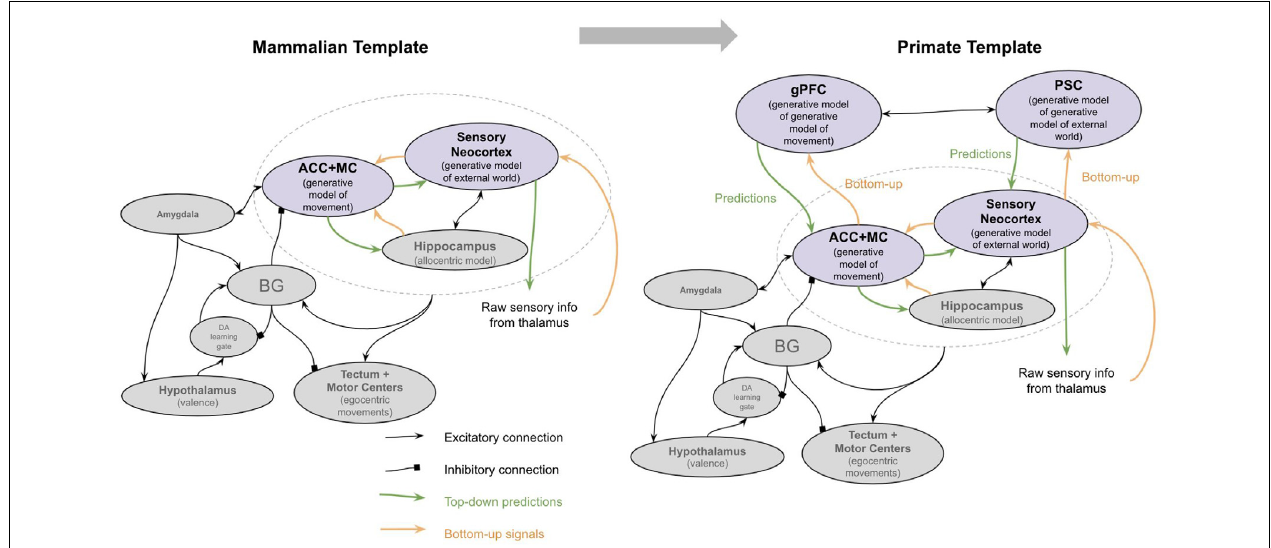
FIGURE 6 | The major brain modifications in early primates. See text for details. PP, Posterior parietal cortex; MC, motor cortex; PSC, polysensory cortex (superior temporal cortex and temporoparietal junction); gPFC, granular prefrontal cortex; ACC, anterior cingulate cortex; BG, Basal ganglia.